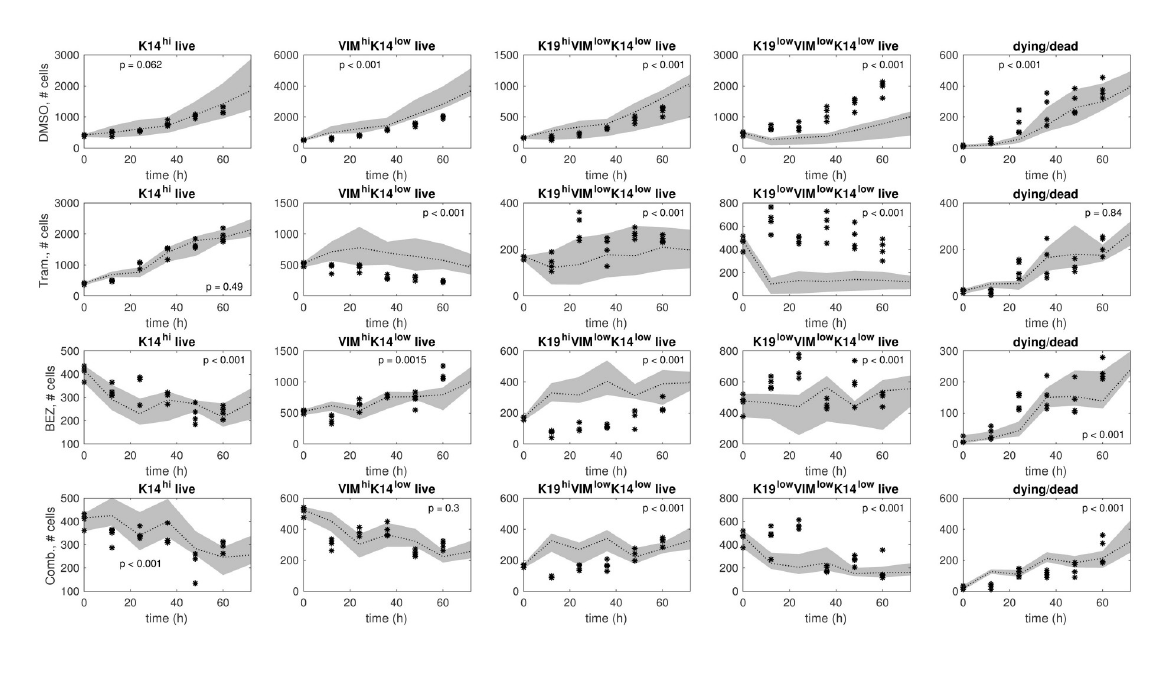
Fig 8. Ensemble model predictions in comparison to test data. The test samples (black stars) and ensemble model predictions (gray bands) are shown for each treatment condition: DMSO (row 1), Trametinib (row 2), BEZ235 (row 3), and Trametinib+BEZ235 (row 4). The model ensemble is a collection of models that were identified from the training data via resampling residuals bootstrap [30] for each treatment condition. In each plot, we show a 95% confidence interval (gray band) around the median (black dotted line) of the ensemble model predictions. Higher p-values indicate better consistency between predictions and test data over the time horizon (12h, 24h, ... , 60h).